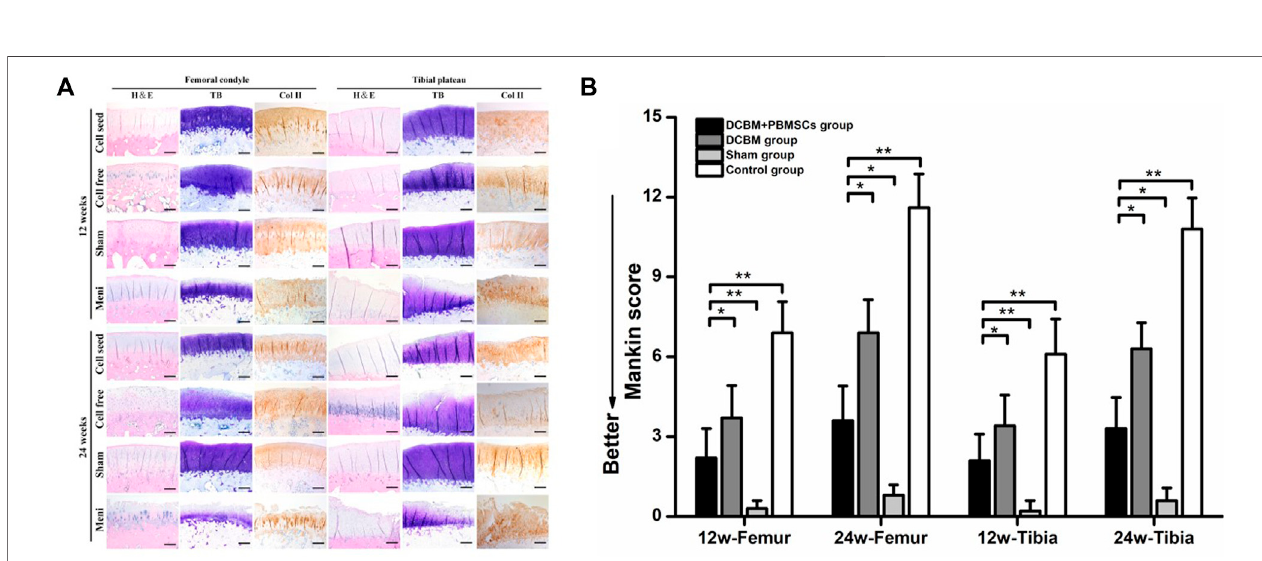
FIGURE 8 | (A) Histological staining and (B) mankin score of articular cartilage. Scale bars = 100 μ m, * p < 0.05, ** p < 0.01.